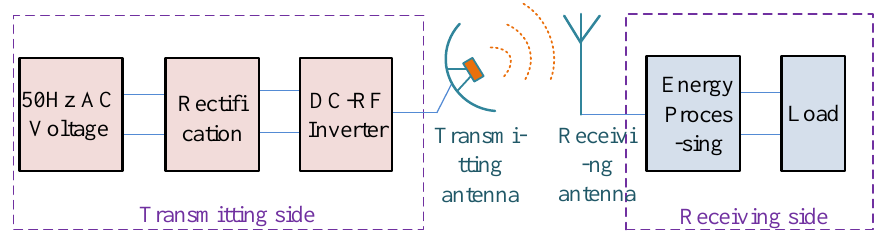
Figure 8. Basic principle of MWPT system.